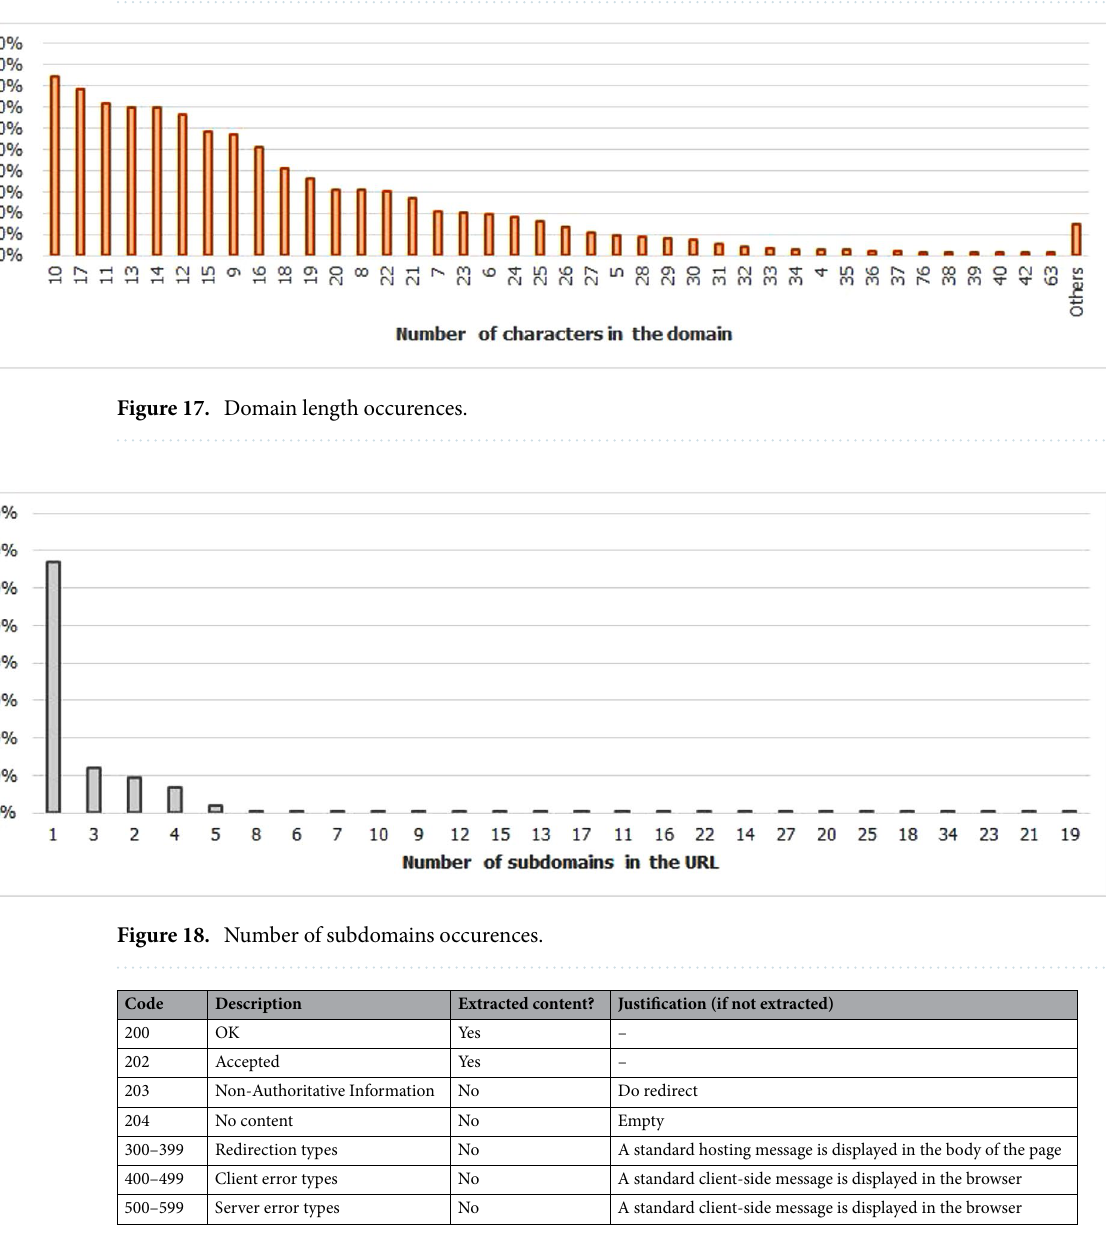
Figure 16. TLD most exploit analysis.